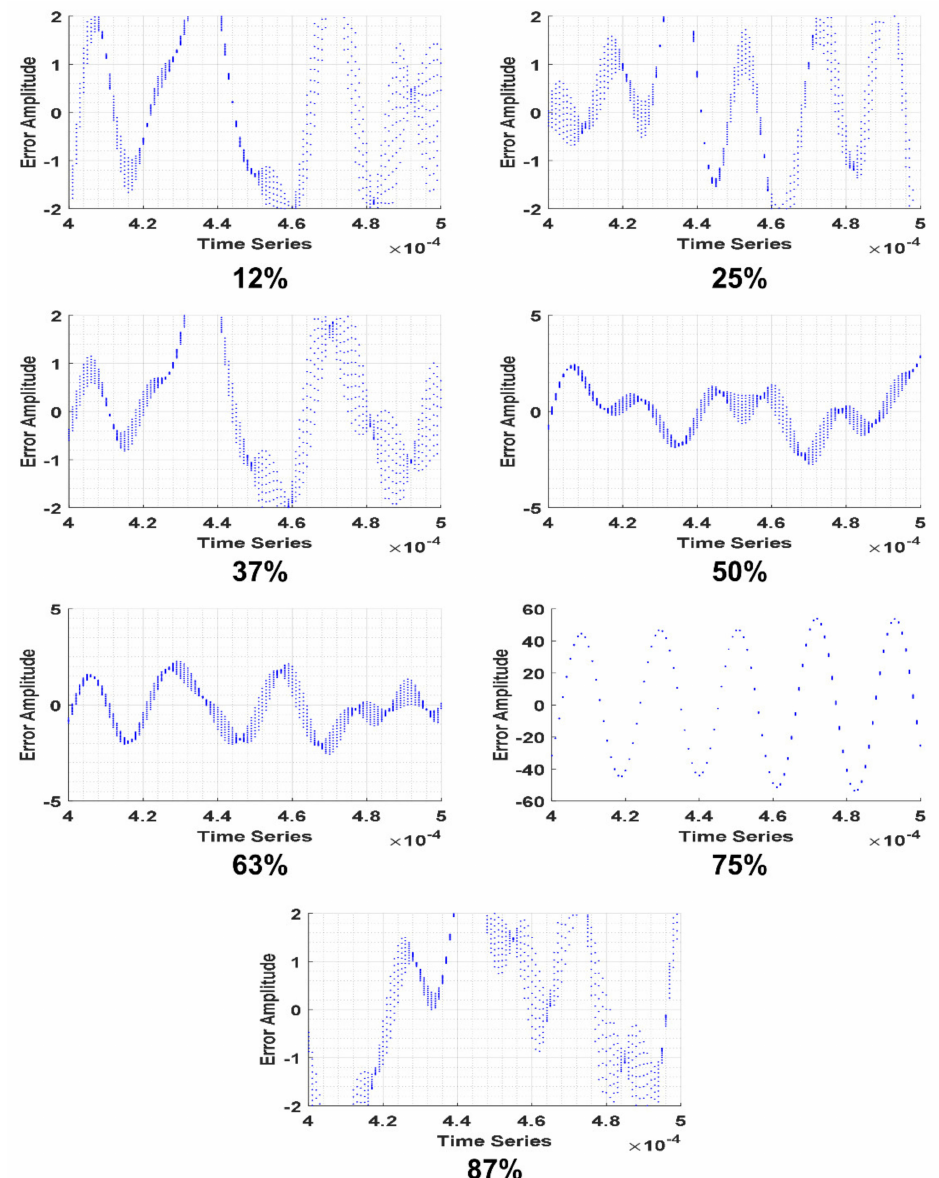
Figure 13. Residual error of the actual signal and model results for cracks at axis